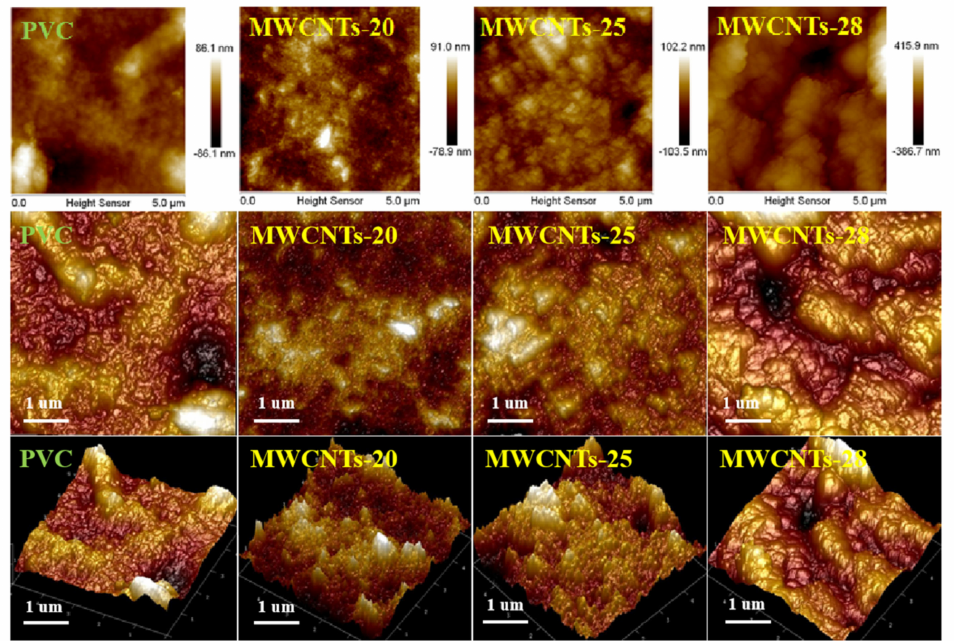
Figure 3. Surface AFM images of the fabricated membranes of PVC, MWCNTs-20, MWCNTs-25, and MWCNTs-28 (from top to bottom, roughness, top view, and perspective